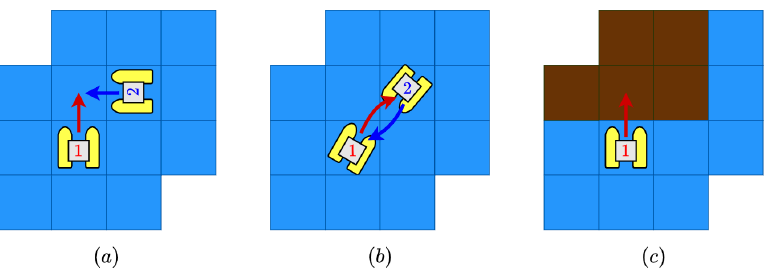
Figure 5. Movements considered collisions in the multi-agent scenario. Every collision is rewarded with a negative penalization. If the collision involves more than one agent, each agent is indepen- dently penalized. ( a ) A same-place collision is depicted. ( b ) A in-transit collision. ( c ) A off-water illegal movement can be